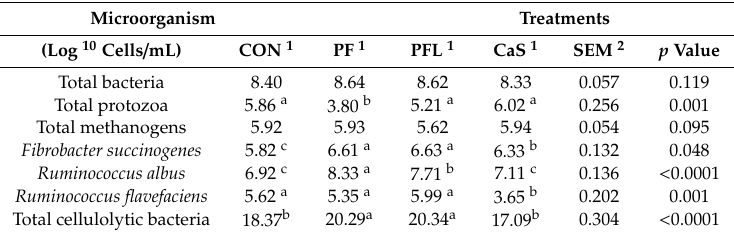
Table 7. E ff ect of di ff erent rumen protected fats on microbial population (copies / mL) in the rumen of Dorper sheep. Microorganism Treatments (Log 10 Cells / mL) CON 1 PF 1 PFL 1 CaS 1 SEM 2 p Value Total bacteria